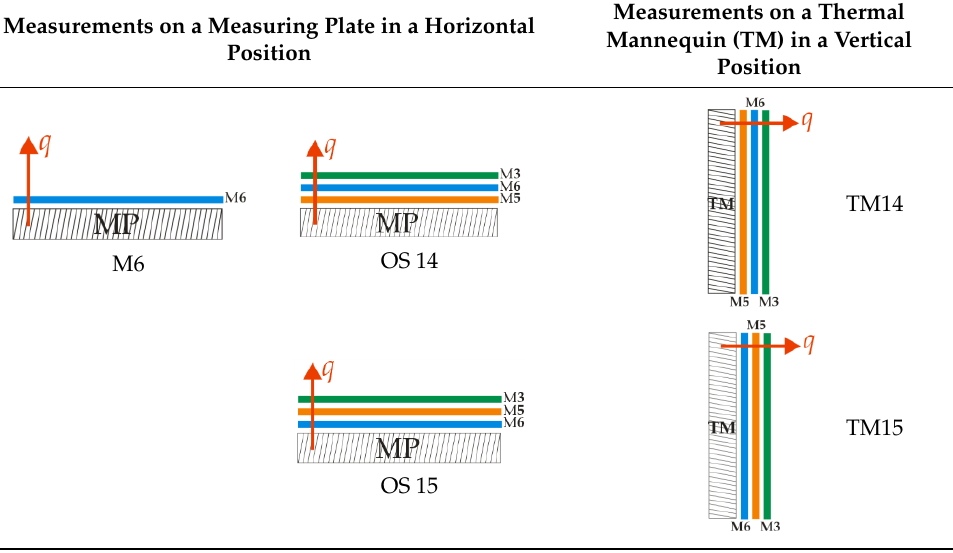
Table 3. Results for the Measurement and Calculation of the Thermal Resistance for Component Textile Materials, Layers of Composite Clothing and Realized Jackets; the Electrical Power Required to Maintain Thermodynamic Equilibrium, the Calculation of the Temperature Gradients and the Algebraic Sum of the Thermal Resistance for all Textile Material Layers in the Composite Clothing are also